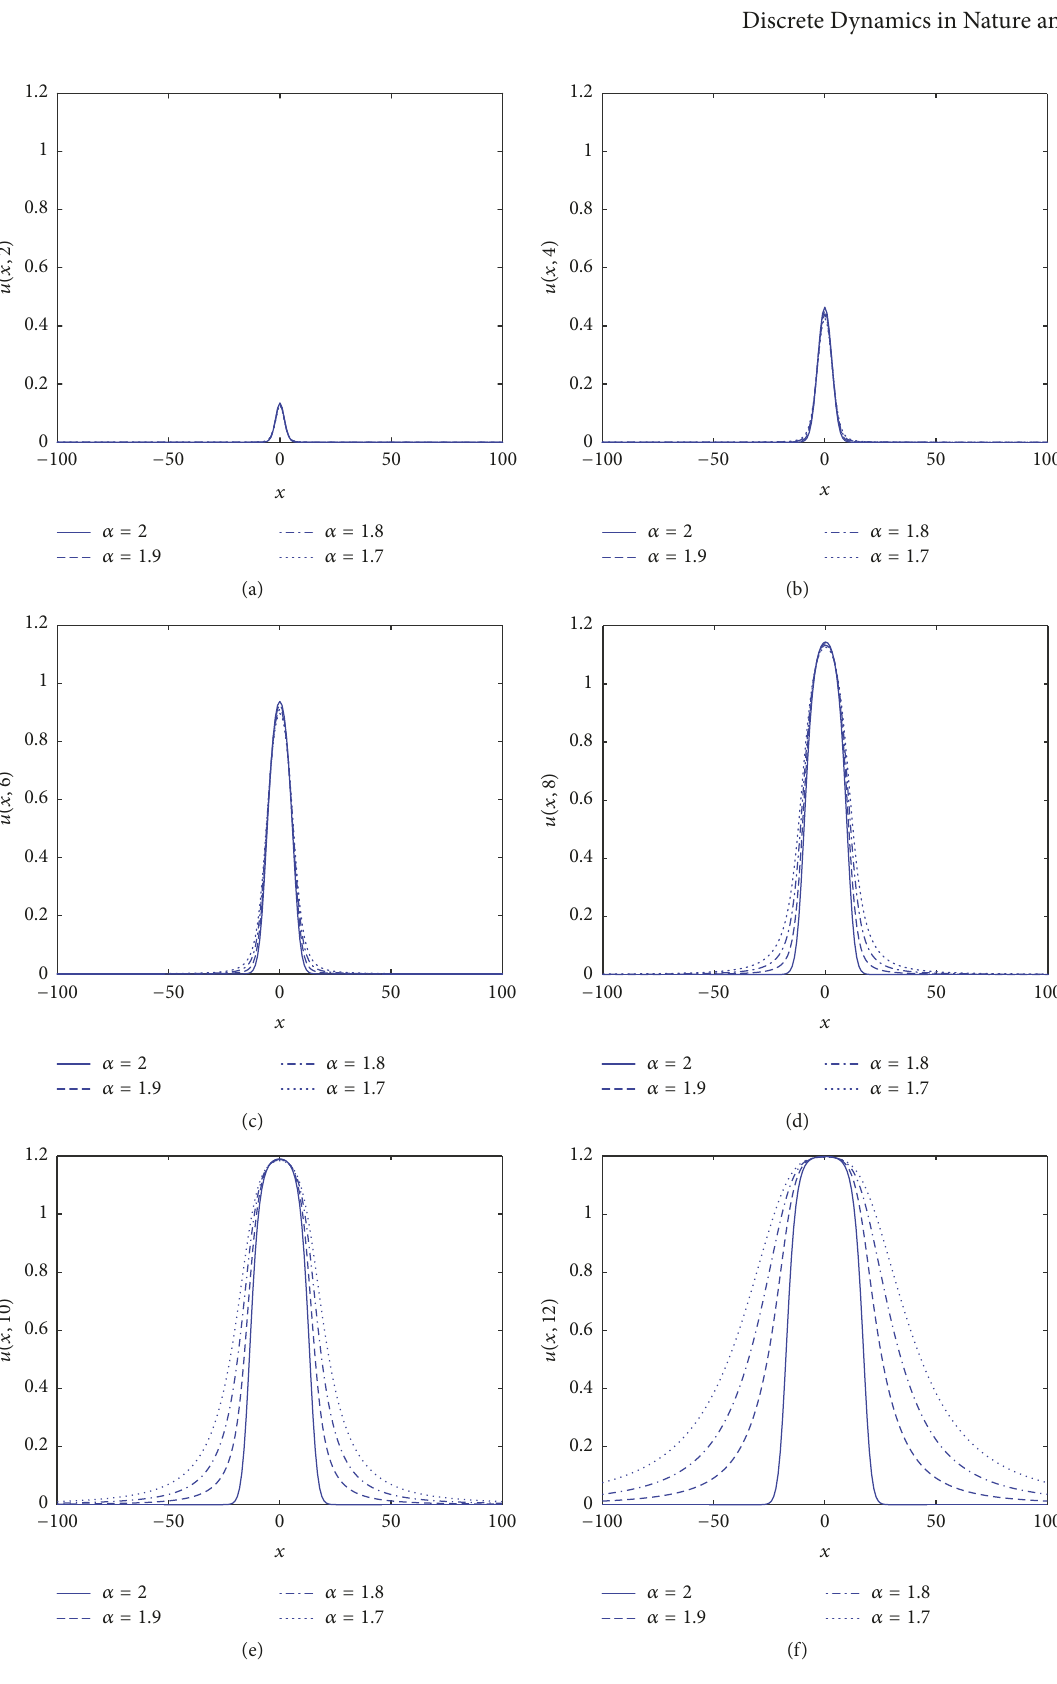
Figure 2: Graph of the solution of the fully discrete model (11) over the spatial domain (−200,200) with 𝜅 = 𝜆 = 1 , 𝐾 = 1.2 , homogeneous Dirichlet boundary data, and initial profile given by (24). Computationally, we used ℎ = 1 and 𝜏 = 0.01 . Various derivative orders were used, namely, 𝛼 = 2 (solid), 𝛼 = 1.9 (dashed), 𝛼 = 1.8 (dashed-dotted), and 𝛼 = 1.7 (dotted). The solutions were calculated at the times (a) 𝑡 = 2 , (b) 𝑡 = 4 , (c) 𝑡 = 6 , (d) 𝑡 = 8 , (e) 𝑡 = 10 , and (f) 𝑡 = 12 . For convenience, the graphs have been plotted on the domain (−100, 100)